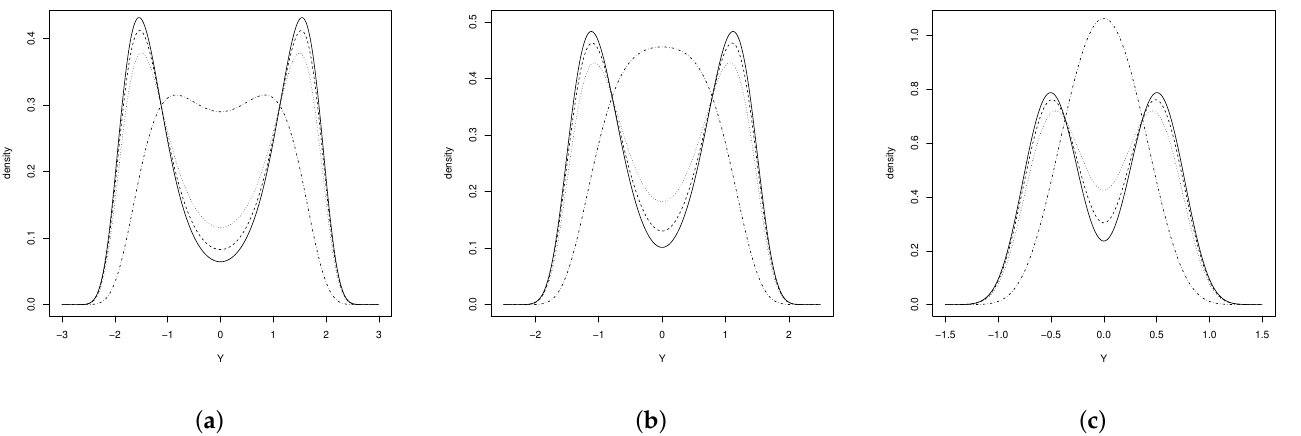
Figure 1. Distribution ( a ) ESHN ( 2.75,0,1, γ ) for γ = 3.5 (solid line), γ = 2.5 (dashed line), γ = 1.5 (dotted line) y γ = 0 (dash-dotted line), ( b ) ESHN ( 1.75,0,1, γ ) for γ = 3.5 (solid line), γ = 2.5 (dashed line), γ = 1.5 (dotted line) and γ = 0 (dash-dotted line) and ( c ) ESHN ( 0.75,0,1, γ ) for γ = 3.5 (solid line), γ = 2.5 (dashed line), γ = 1.5 (dotted line) and γ = 0 (dash-dotted